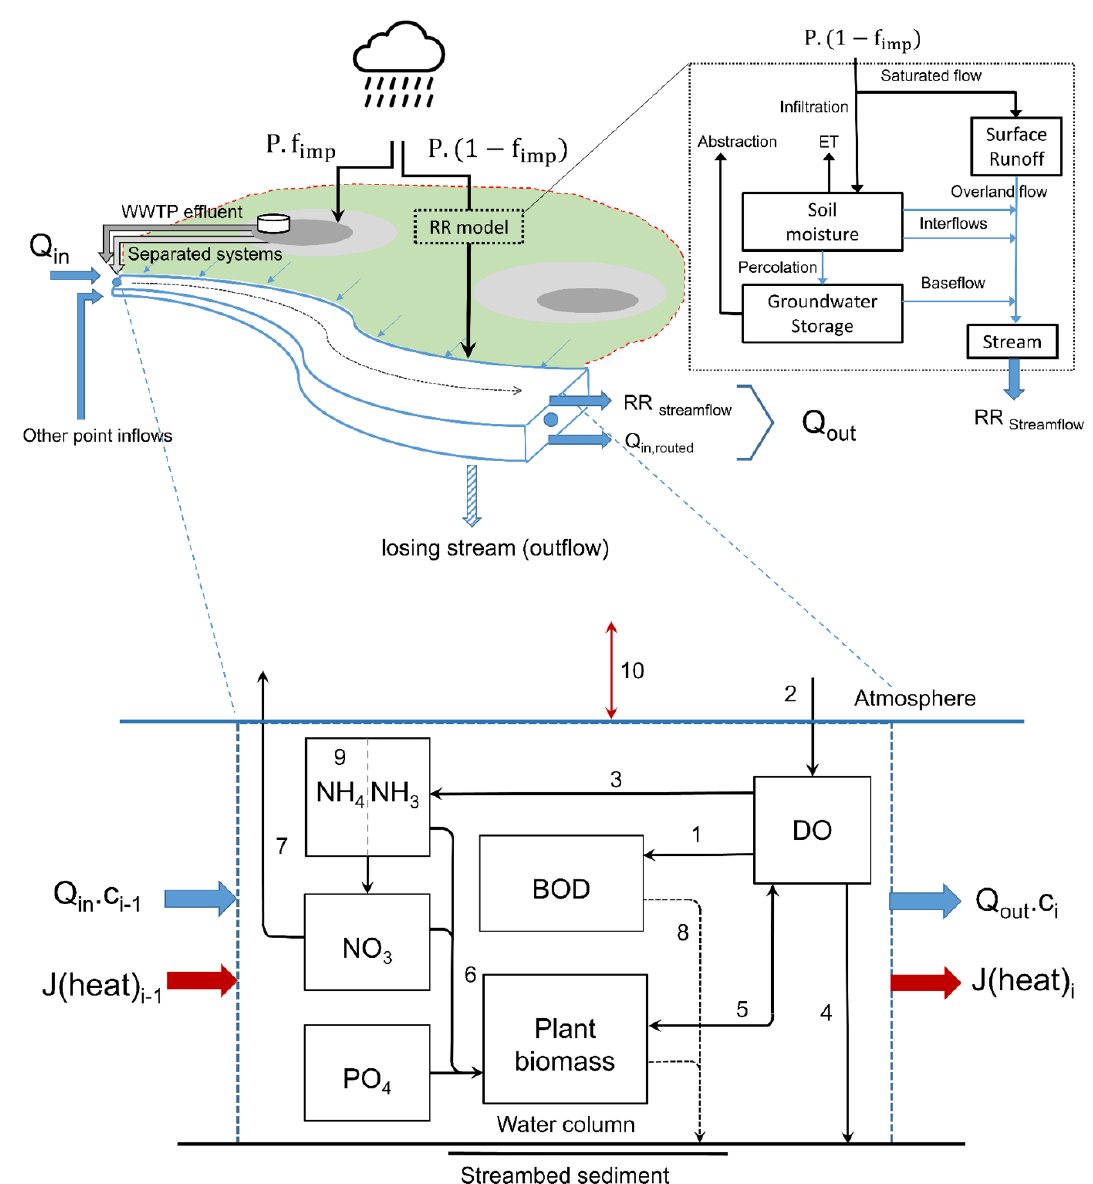
Figure 1. Conceptual model structure for a single reach encompassing the key hydrological (upper) and in-stream water quality (lower) processes. Key interconnecting processes for water quality given as numbers include: (1) carbonaceous biochemical oxygen demand, (2) reaeration, (3) nitrification, (4) sediment oxygen demand, (5) photosynthesis/autotrophic respiration, (6) nutrient assimilation, (7) denitrification, (8) settling, (9) ammonium/ammonia partitioning (pH-dependent), and (10) water-atmosphere heat exchange. All processes are temperature-dependent. Abbreviations are defined in the related Sections 2.2.1 and 2.2.2.